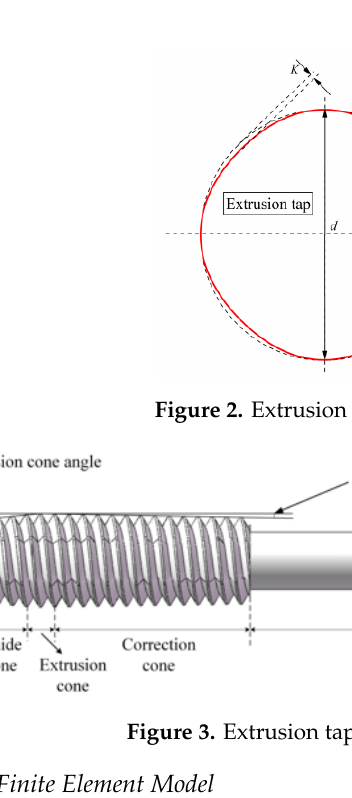
Table 1. Extrusion conditions of 45 # steel.